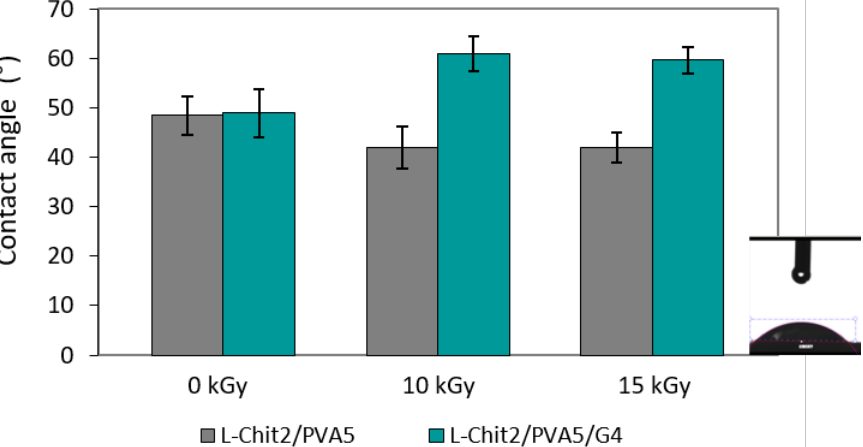
Figure 4. Contact angle of non-irradiated and γ -irradiated low Mw chitosan/PVA-based membranes (n = 3; mean value + SD; the inset on the right side depicts the droplet falling pipe and the water over the surface after contact).